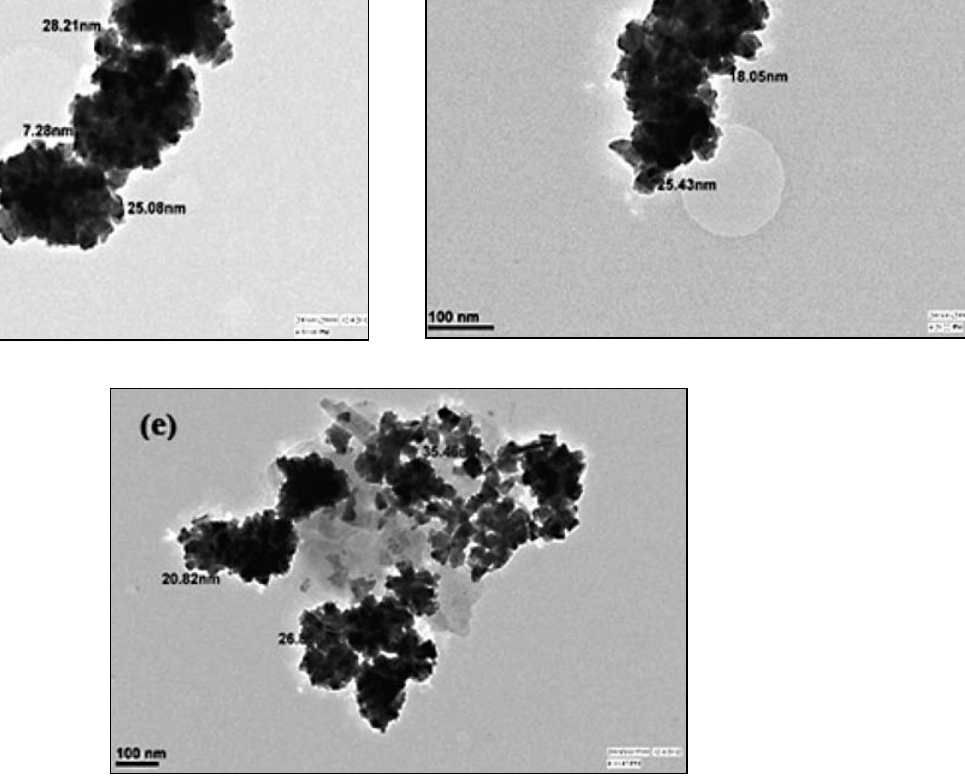
Figure 3. TEM images for (a) undoped CdS (b) CdS:Cu 2+ (c) CdS:Cu 2+ Gd 3+ (d) CdS:Cu 2+ Er 3+ (e) CdS:Cu 2+ Tb 3+